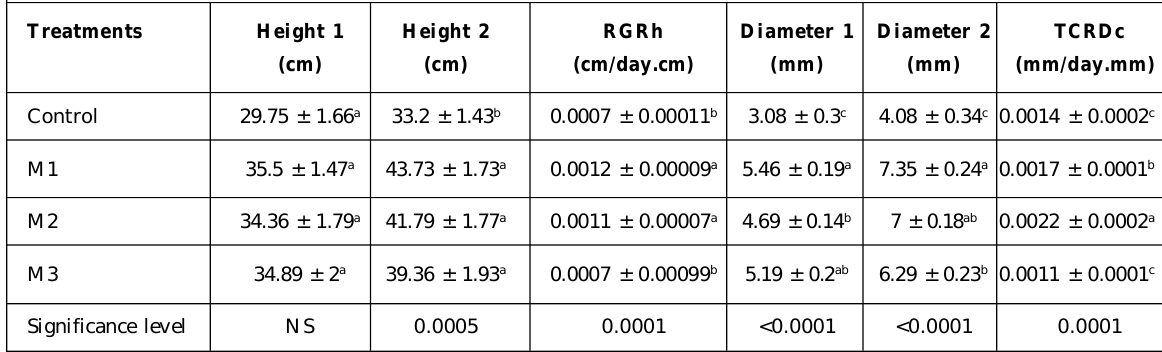
Table 1: Plant height, the collar diameter, the rate of relative growth in height and the rate of relative growth of the collar diameter of Sclerocarya birrea inoculated or not with 3 mycorrhizal inocula (M1, M2 and M3)